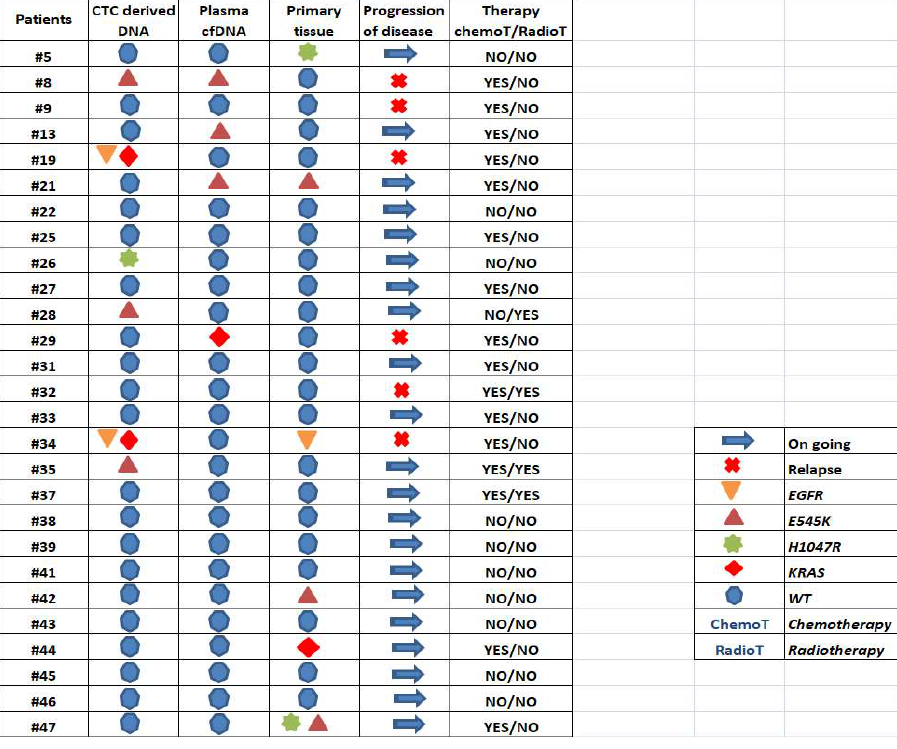
Figure 3. Direct comparison of tested mutations detected in primary tissue, plasma-cfDNA and CTC-derived